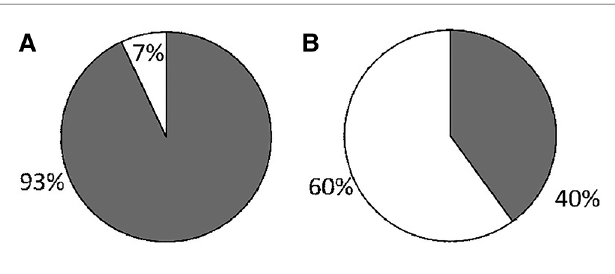
FIGURE 2 Caregiver-reported impression of PCP ’ s knowledge of vaccination in ICC compared to PCP-reported con fi dence when providing vaccines to ICC. Grey: Well informed; White: Not well informed. 2A: Caregiver report. 2B: PCP report.